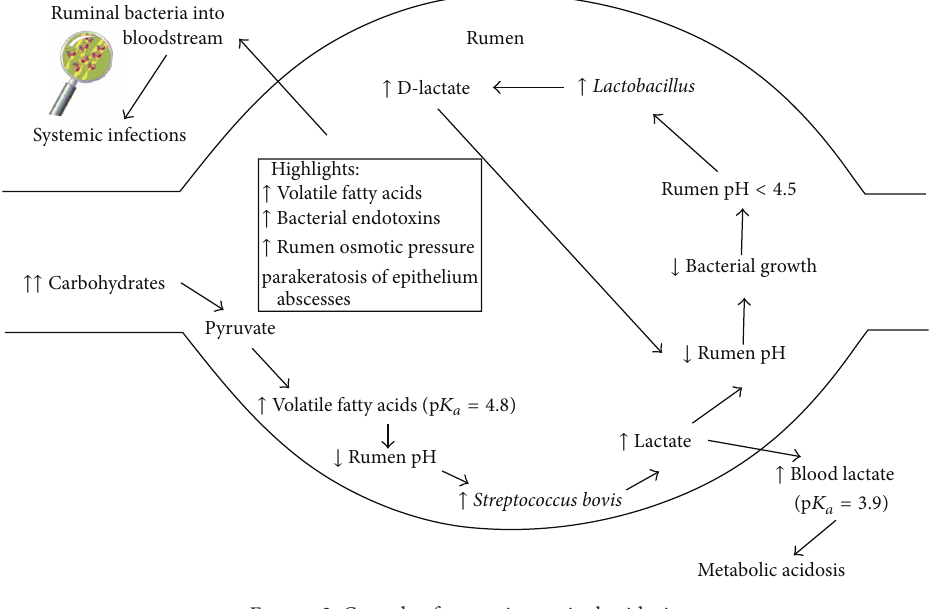
Figure 2: Cascade of events in ruminal acidosis.